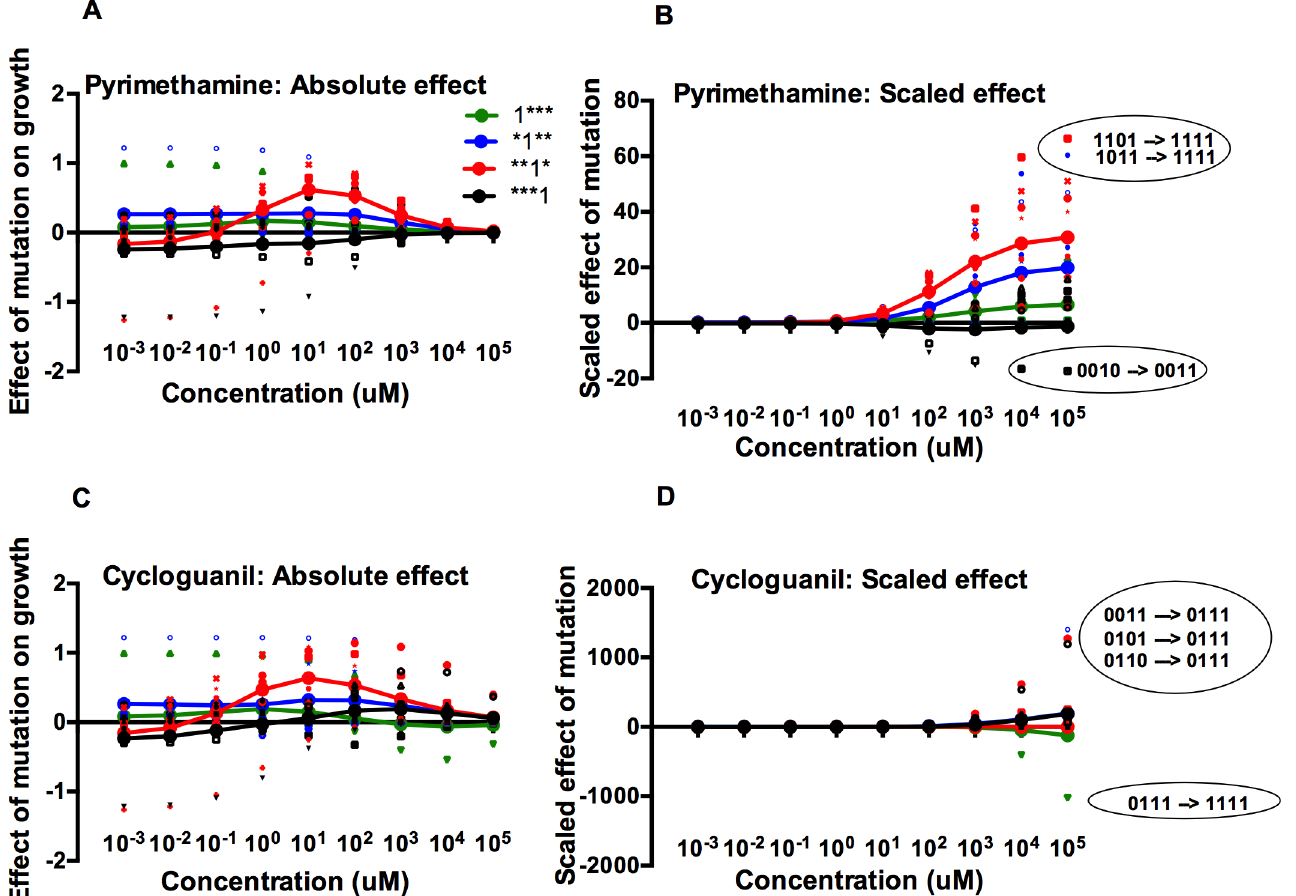
Fig 4. The effect of mutations changes as a function of drug environment and genetic background, with prominent epistasis. Each color represents the effect of a particular mutation. Small (unconnected) symbols represent individual mutational effects in a particular genetic background; large symbols (connected by lines) represent the average mutational effects over all genetic backgrounds. The scatter of the smaller symbols around the large ones indicates that individual effects are dependent on genetic background, the signature of epistasis. (A) and (B) represent the calculations for pyrimethamine (absolute and scaled, respectively), with (C) and (D) representing the calculations for cycloguanil. For 4B and 4D, units are in relative effects of mutation, a property determined by the absolute fitness effect divided by the growth rate of the ancestor (0000). (B) and (D) are also marked with circles and labels that identify especially large epistatic interactions (labeled in terms of the mutational events that produce the notable fitness effect) at particular drug concentrations. Due to the large differences in scaled effects for the two drugs, the y -axes for B and D have different ranges. Though epistasis can be observed here, the standard deviation in fitness effects was measured directly and plotted in S2 Fig. In 4D, the 0011 ! 0111 mutation effect is slightly offset (vertically) so that it can be distinguished from the 0101 ! 0111 mutation effect. higher drug concentrations. The third site, (cid:1)(cid:1) 1 (cid:1) , has a statistically significant interaction with drug concentration (absolute effect: P = 0.00081) with the fourth site, (cid:1)(cid:1)(cid:1) 1 having a nearly sig- nificant interaction across environments (absolute effect: P = 0.05). These findings relate to the